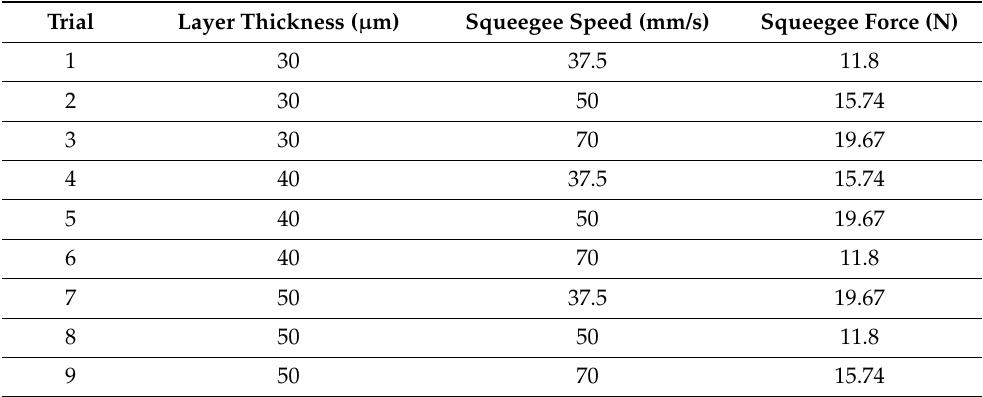
Layer Thickness ( µ